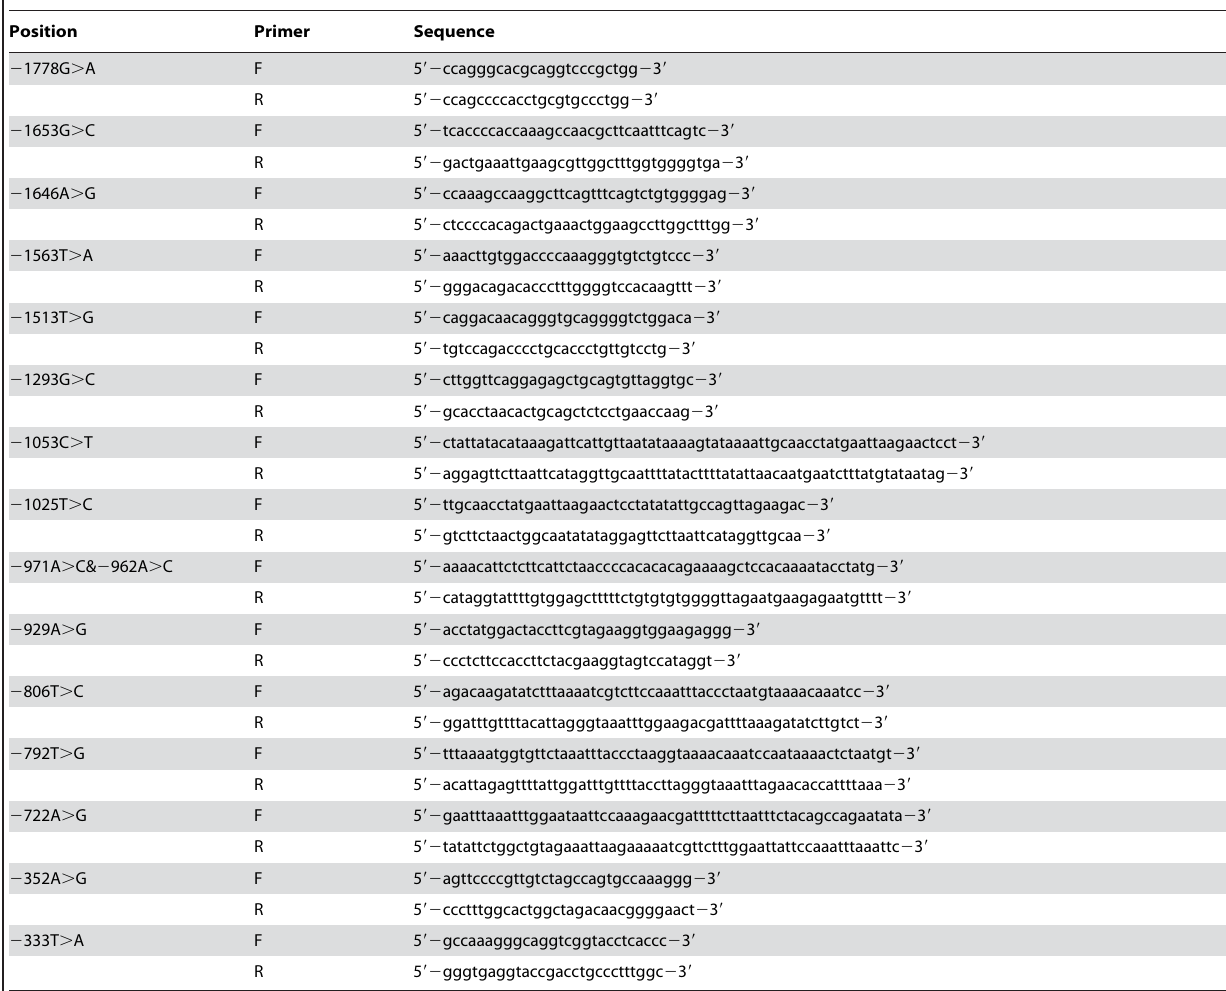
Table 4. Primer sequences for site-directed mutagenesis.